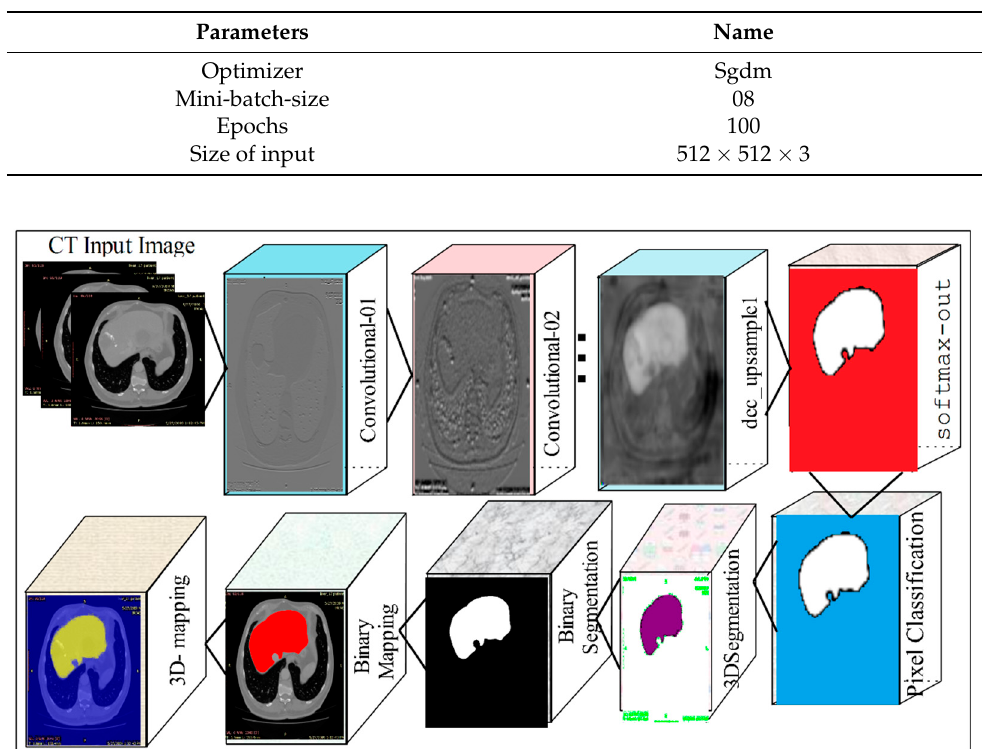
Figure 4. The proposed semantic segmentation paradigm. Table 4. Learning parameters.